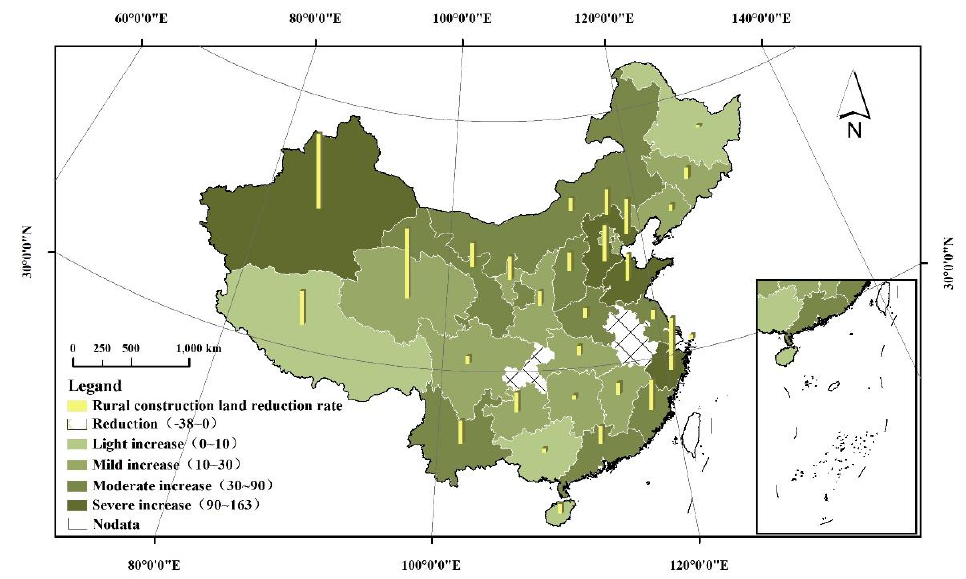
Figure 3. Space pattern of the absolute increase and average annual growth rate of rural construction land areas from 2009 – 2016. land areas from